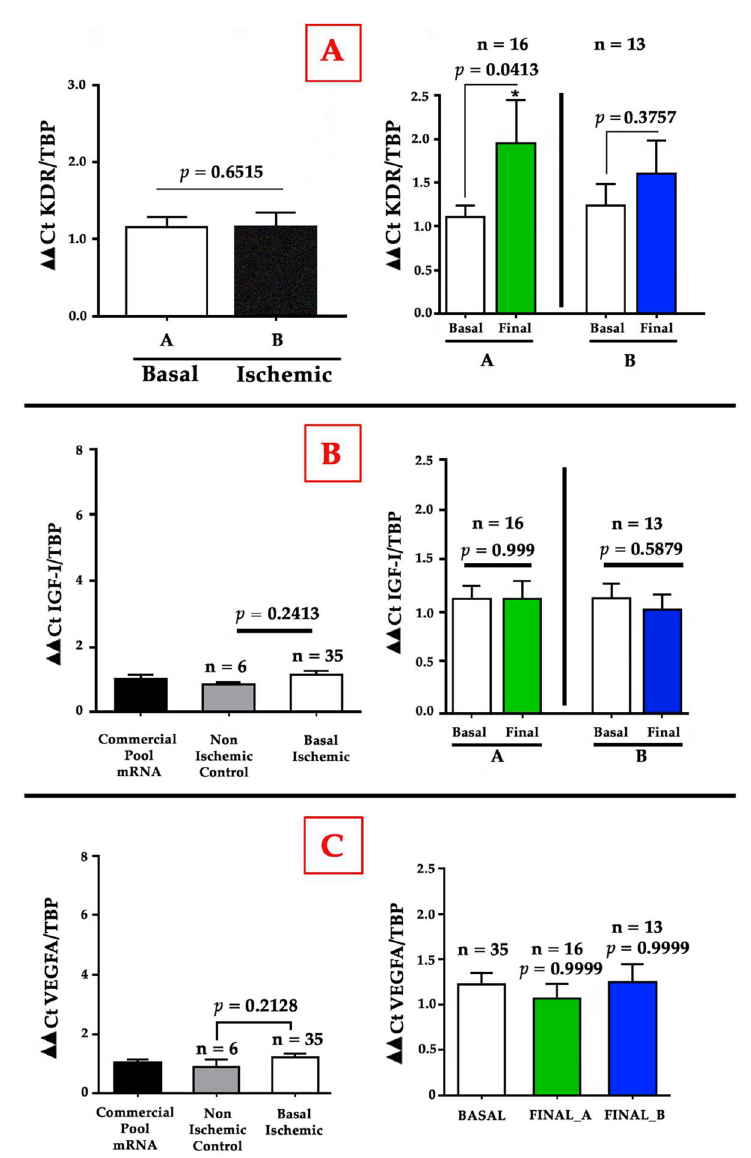
Figure 6. GH increases VEFGA-R2 or KDR / Flk-1 mRNA levels in ischemic muscles of patients with critical limb ischemia without apparent changes in IGF-I and vascular endothelial growth factor A (VEGFA) mRNA levels. Insights from the GHAS trial. ( A ). VEFG-R2 or KDR / Flk-1 mRNA levels in the GHAS trial. The left graph shows the baseline levels between both groups of treatment with no significant di ff erences. In the right graph, a significant increase in KDR mRNA levels in the GH group compared to the placebo group were found during the period of treatment (8 weeks). ( B ). IGF-I mRNA levels in the GHAS trial. The graph on the left shows levels of IGF-I at baseline in ischemic vs non-ischemic muscle samples with no di ff erences. The graph on the right shows the lack of changes in any group of treatment during the period of treatment. ( C ). VEGFA mRNA levels in the GHAS trial. The left graph depicts the comparation between VEGFA levels in ischemic vs non-ischemic muscle samples in the calf at baseline. The right graph depicts the lack of significant changes after 8 weeks of treatment. Group A, green bars: GH; Group B, blue bars: placebo. Non-ischemic muscle samples: sample of reference obtained from amputations in patients without limb ischemia. Commercial pool mRNA: a commercial mRNA from skeletal muscle used as a technical control for normalization of the di ff erent assays. A non-parametric test was used for the statistics. Note that although at the beginning of the study there were data from 35 muscle samples, at the end of this study, there were only complete data from 28 patients (basal and final samples). * indicates statistically